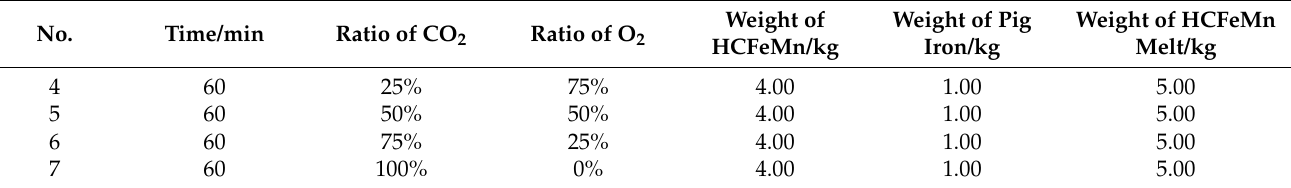
Table 3. Experimental scheme of formal